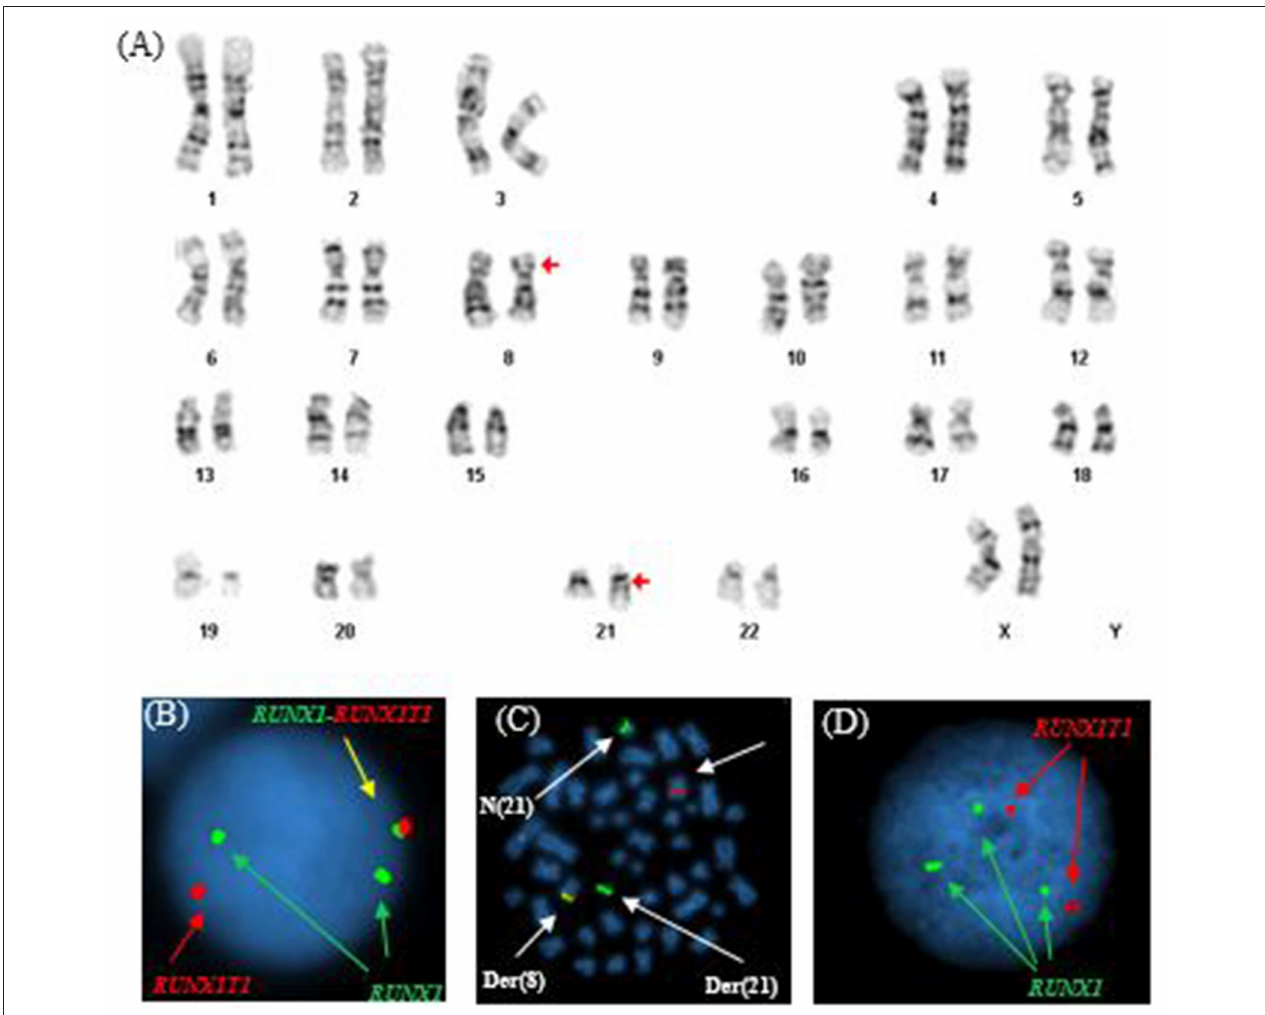
FIGURE 2 | Abnormal cytogenetic and FISH findings in Patient #2. (A) Representative karyogram of an apparent t(8;21)(q22;q22) observed in all of 20 metaphases analyzed, unable to show submicroscopic small deletions due to cytogenetic technic limitation. The aberration was re-written as der(8)t(8;21)(q22;q22),der(21)t(8;21)del(8)(q22q22) based on FISH findings in (B,C) . Arrows indicate aberrant chromosomes. Chromosome numbers are listed on the bottom. (B) Interphase FISH study using dual color dual fusion probes demonstrating an atypical pattern with one fusion signal for RUNX1-RUNXT1, one signal (red) for the RUINX1T1 locus, and two signals (green) for the RUNX1T1 locus. (C) Metaphase FISH study using dual color dual fusion probes demonstrating a derivative chromosome 8 [der(8)] carrying a fusion signal of RUNX1T1 and RUNX1, a derivative chromosome 21 [der(21)] carrying the green colored RUNX1 signal alone consistent with a sub-microscopic deletion of the rearranged 8q22 segment encompassing the 5 ′ RUNX1T1, a copy of a normal chromosome 8 [N(8)] and a copy of a normal chromosome 21 [N(21)]. (D) Interphase FISH study using dual color dual fusion probes demonstrating a second atypical pattern with two signals (red) for the RUINX1T1 locus, three signals (green) for the RUNX1T1 locus and no fusion signal for RUNX1-RUNXT1.